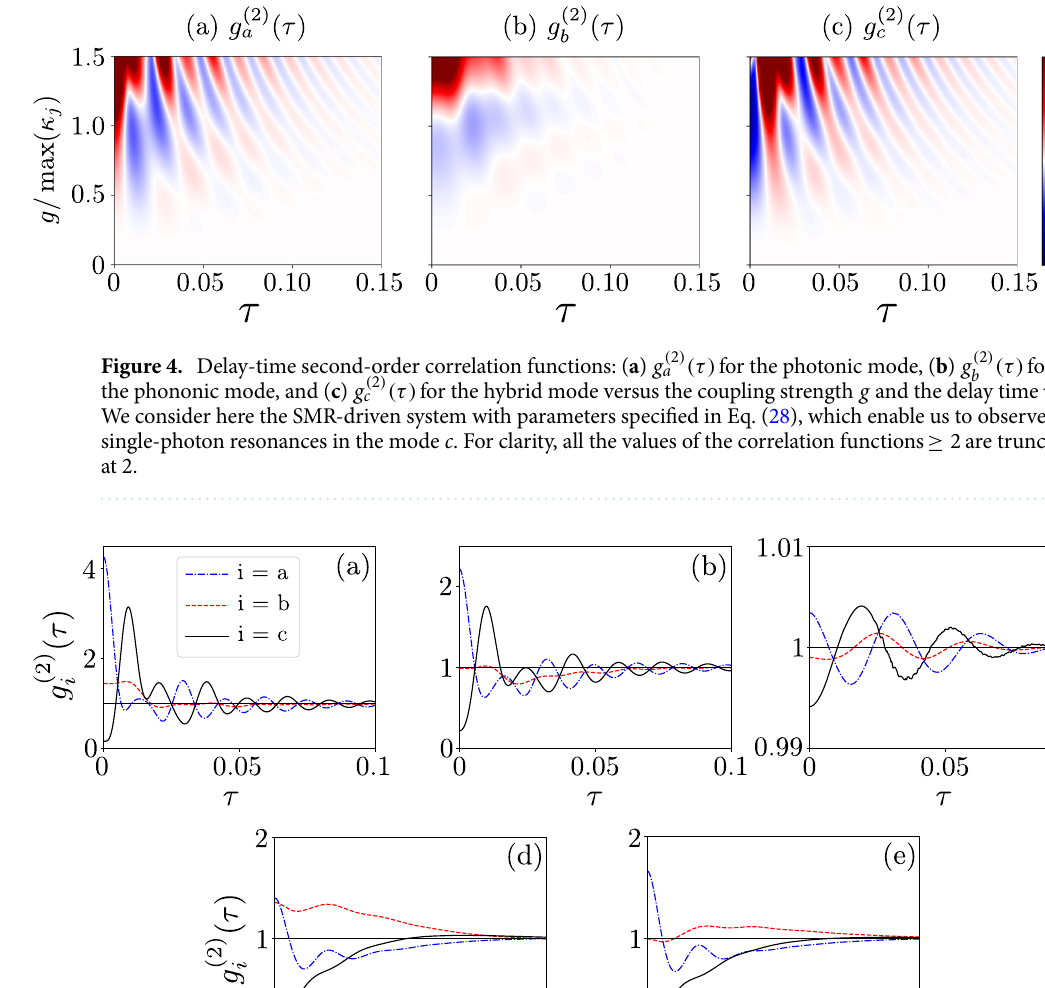
( 2 ) (τ) for the SMR mode a , the QD mode b , and Figure 5. Delay-time second-order correlation functions g i 5.5 γ and the hybrid mode c modes assuming: ( a – c ) the SMR-driven system specified in Eq. (28) with f = κ max κ b 6 γ , and ( d , e ) the QD-driven system in Eq. (29) with κ max 7.5 γ , where we additionally set: = = = 1.3 κ max 7.8 γ , ( b ) g 1.1 κ max 6.6 γ , ( c ) g 0.2 κ max 1.2 γ , ( d ) g 0.7 κ max 5.25 γ , and ( e ) ( a ) g = = = = = = = = g 0.758 κ max 5.685 γ = =